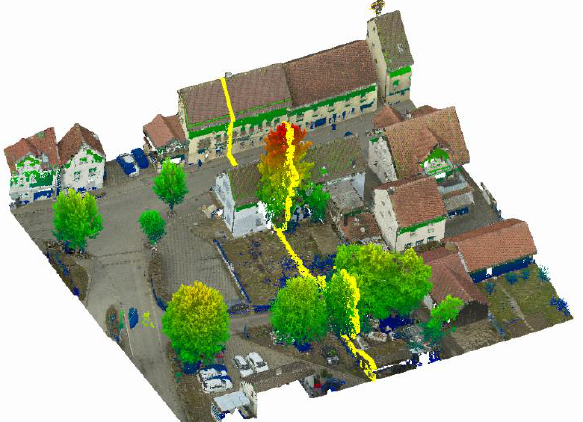
Figure 7. Comparison of 3D points from MVS (RGB) and LiDAR measurement (height coded). Yellow line defines profile depicted in Figure 8.